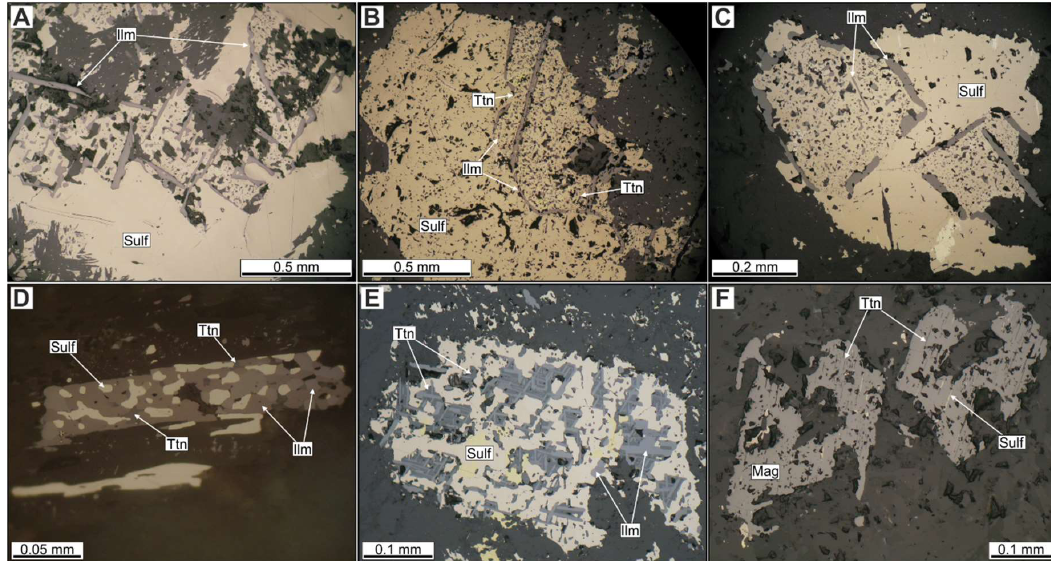
Figure 3. Reflected light microphotographs demonstrating ilmenite–sulfide and ilmenite–titanite relationships in the metamorphosed mafic-ultramafic rocks of the Sedova Zaimka intrusion. ( A ) “Octahedral mesh” of ilmenite in sulfides: coarse lamellae of ilmenite are parallel to the octahedral parting planes of the relict magnetite. Numerous microscopic rod-like and elongated grains of ilmenite also occur between coarse lamellae. No titanite is observed (sample 13-109.6); ( B ) ilmenite-laden domains in sulfides with cord-like ilmenite, marking the boundaries of relict magnetite grains. Titanite occurs in sulfides as small, individual, anhedral grains distributed between coarse ilmenite lamellae and coexisting with cord-like ilmenite (sample 13-109.6); ( C ) ilmenite-laden domains in sulfides with cord-like ilmenite. No titanite is observed (sample 13-109.6); ( D ) polycrystalline ilmenite aggregate in meta-ultramafic rock. Ilmenite coexists with titanite and sulfides (sample 119-37.4); ( E ) complex grain in metagabbro, consisting of trellis-type ilmenite lamellae in titanite. Lamellae of ilmenite are parallel to three sets of {111} lattice planes of the magnetite structure. Coexisting sulfides are later with respect to both titanite and ilmenite (sample 13-64.5); ( F ) thin subparallel lamellae of titanite in magnetite grains (sample 13-109.6). Abbreviations: Ilm = ilmenite, Mag = magnetite, Sulf = sulfide, Ttn = titanite.